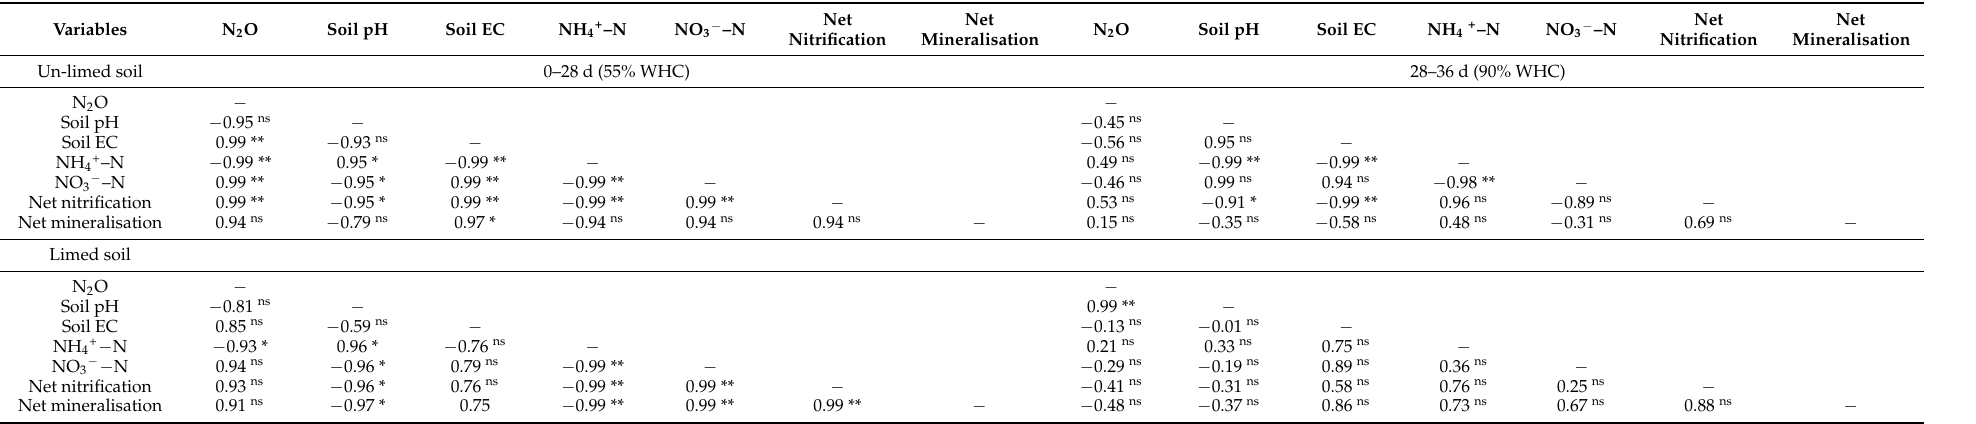
Table 3. Pearson’s correlation among variables of various treatments in the un-limed and limed sugarcane cropped soil. The soil water was maintained at 55% WHC for the first 28 d then increased to 90% WHC for the remainder of the experimental period. Data are the means of four replicates ±